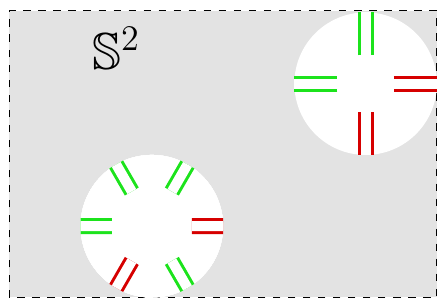
Figure 1 . The gray part is an abstract representation of a multi-matrix model planar graph (after ‘vulcanizing’ the unbroken faces and forgetting everything but broken faces) with two faces broken by uncontracted half-edges. These boundaries determine the external leg structure decorating the cylinder (the two broken faces are interpreted as excised discs from here). The 4-leg boundary S 2 in the upper right corner yields the cyclic word ABBA (or AABB , or . . . ); the 6-legged one is AABABA (or AAABAB, . . . ). The external leg structure is the disjoint union of these